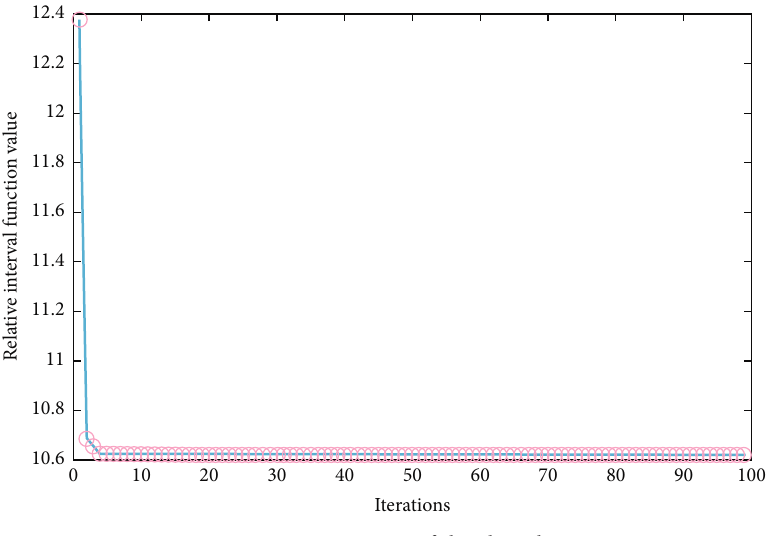
Figure 7: Convergence of the algorithm. Table 9: Vulnerability identification results based on network connectivity and network efficiency (partial